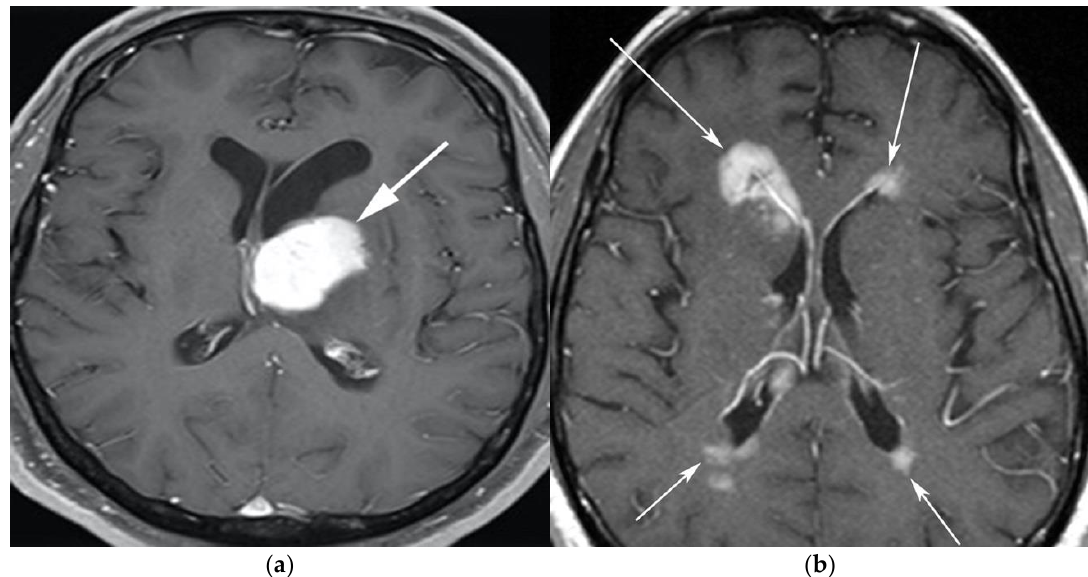
Figure 1. A 65-year-old man presenting with headache. ( a ) Axial T1 post-contrast fat-suppressed image shows homogenous enhancing mass within the left thalamus (white arrow) with mass effect on the 3rd ventricle and left putamen laterally. ( b ) Axial T1 post-contrast fat-suppressed images in a different patient show infiltrative periventricular soft tissue masses (white arrows). Both cases were pathologically proven primary central nervous system lymphoma-diffuse large B-cell histologic subtype.